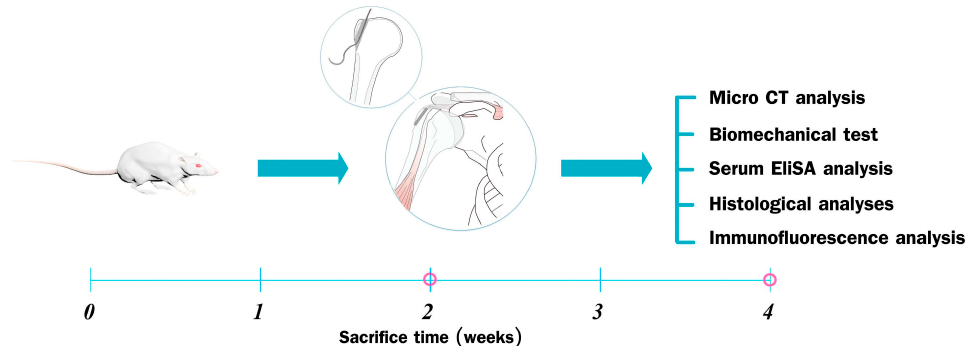
Figure 7. Study design in vivo. All Sprague Dawley rats were randomly divided into a control